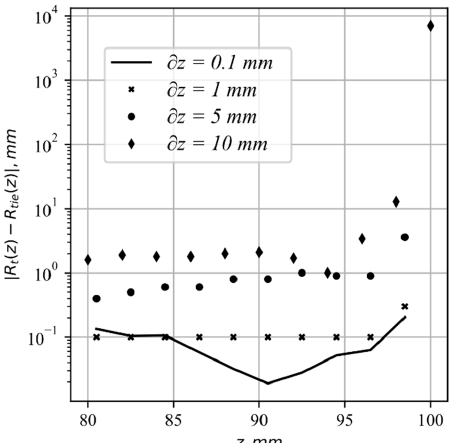
ment of the between planes where intensity distributions were acquired was carried out in [49].